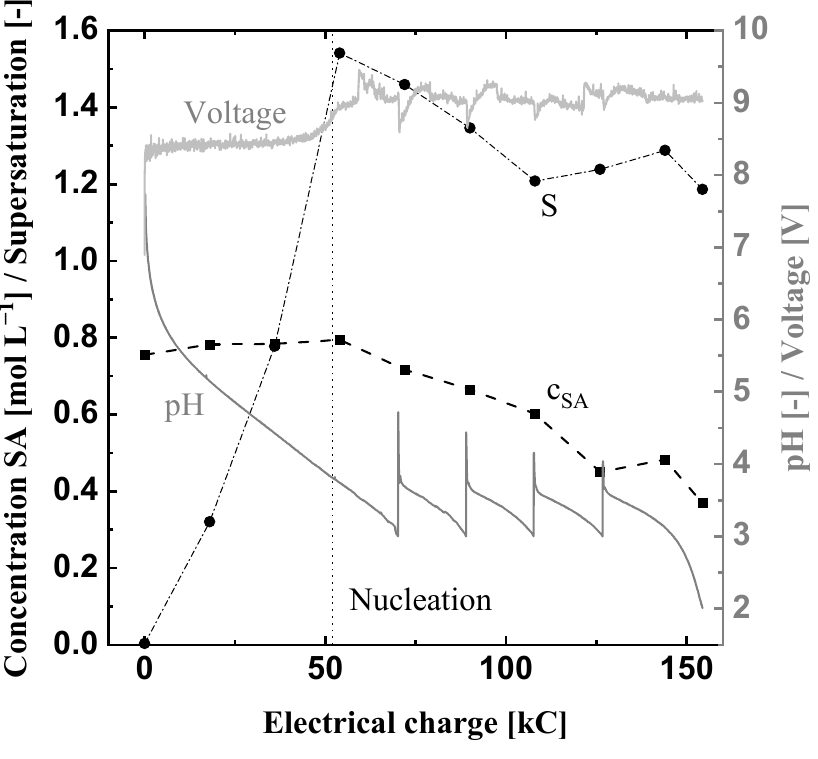
Figure 5. Electrochemical pH-shift crystallization in the prototype at 10°C, 0.1Acm − 2 and a volume flow rate ˙V of 0.52Lmin − 1 (Exp1). The black squares are the measured succinic acid concentration, the black cycles show the calculated supersaturation ratio S, and the two gray lines display the course of the pH value and voltage of